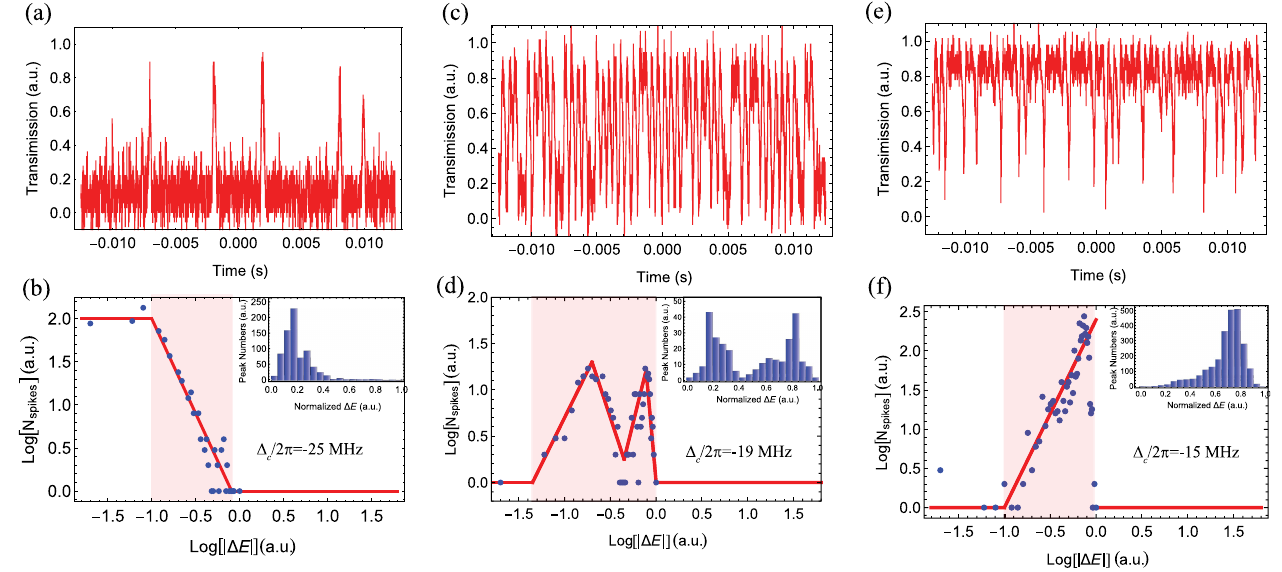
FIG. 7. Characterizing the size of transition avalanches via probe transmission for different excitation rates. The system is predominantly in the NI phase, with Δ E ¼ 0 defined as minimum transmission [(a), Δ Δ = 2 π ¼ − 19 MHz], and predominantly in the I phase with Δ E ¼ 1 defined as maximum transmission [(e), Δ c distributions of Δ E shown in panels (b), (d), and (f) exhibit power-law scaling in the shaded regimes. We find exponents j b j ¼ 2 . 2 (b); j b j ¼ 2 for − 1 . 35 < Δ E < − 0 . 7 , 3 for − 0 . 75 < Δ E < − 0 . 35 , 4 for − 0 . 35 ≪ Δ E ≪ − 0 . 11 and 11 for − 0 . 11 ≪ Δ E ≪ 0 (d); and j b j ¼ 2 . 4 (f), respectively. The insets show histograms of the transmission levels. The probe is constant at Ω p = 2 π ¼ 6 . 2